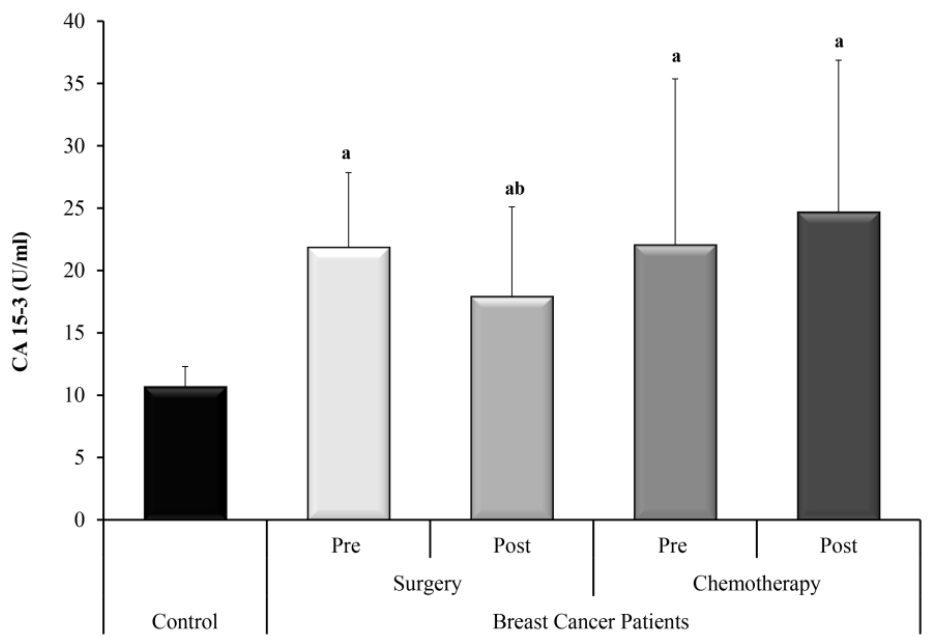
Figure 1. The levels of CA 15-3 in control subjects and BC groups; surgery and adjuvant chemotherapy. a—Significant between control and each group by using Post Hoc Test (Tukey) for ANOVA test, b—Significant between pre and post in same group by using Paired t